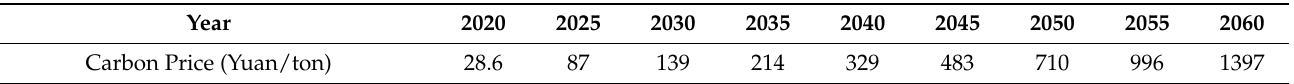
Table 11. Prediction on carbon price in 2020–2060.